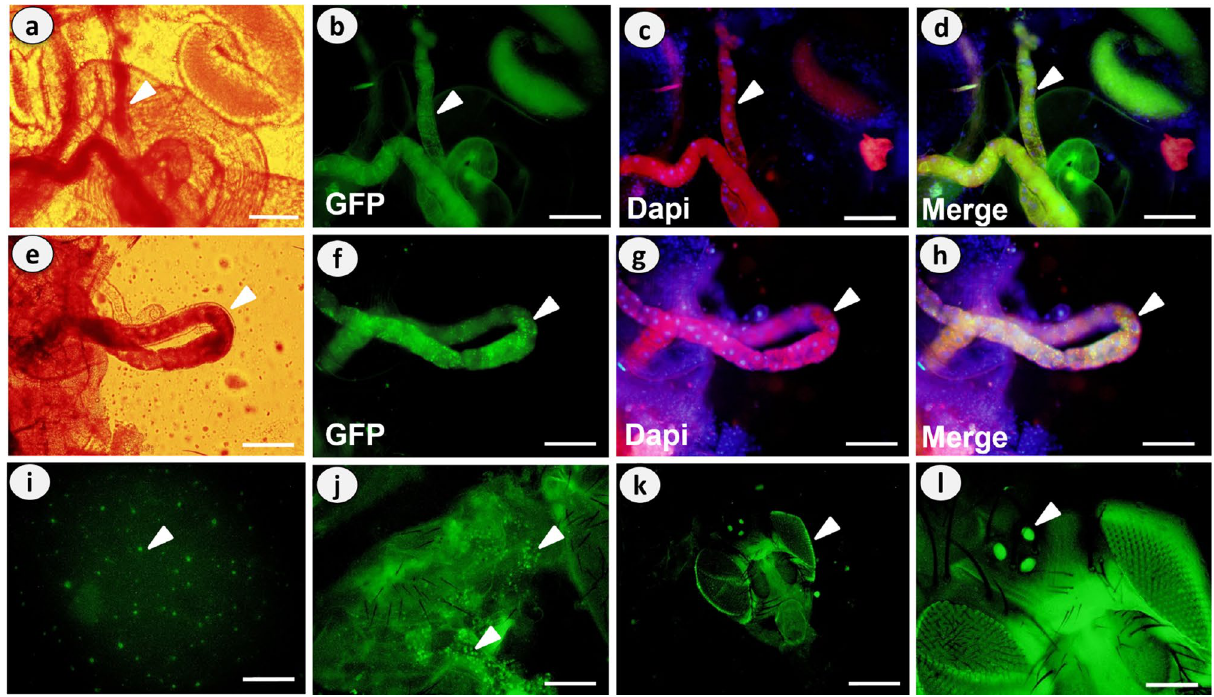
Figure 6. Showing the tissues of adult D. melanogaster flies that fed on food media-supplemented with different concentrations of green-yellow, fluorescent polystyrene microplastics (PS-MPs) for 7 days. Tissues were stained immunohistochemicaly using anti-GFP antibody (green florescent micrograph) and with DAPI fluorescent stain which turned the nuclei blue and the overlay of these two florescent micrographs revealed the presence and distribution of PS-MPs in the alimentary canal ( a - d ), and Malpighian tubules ( e – h ), hemolymph ( i ), body cavity ( j ) and in compound eyes and ocelli ( k & l ). Scale bar: 50 µm ( a - h ), 200 µm ( i , j and l ) and 100 µm ( k